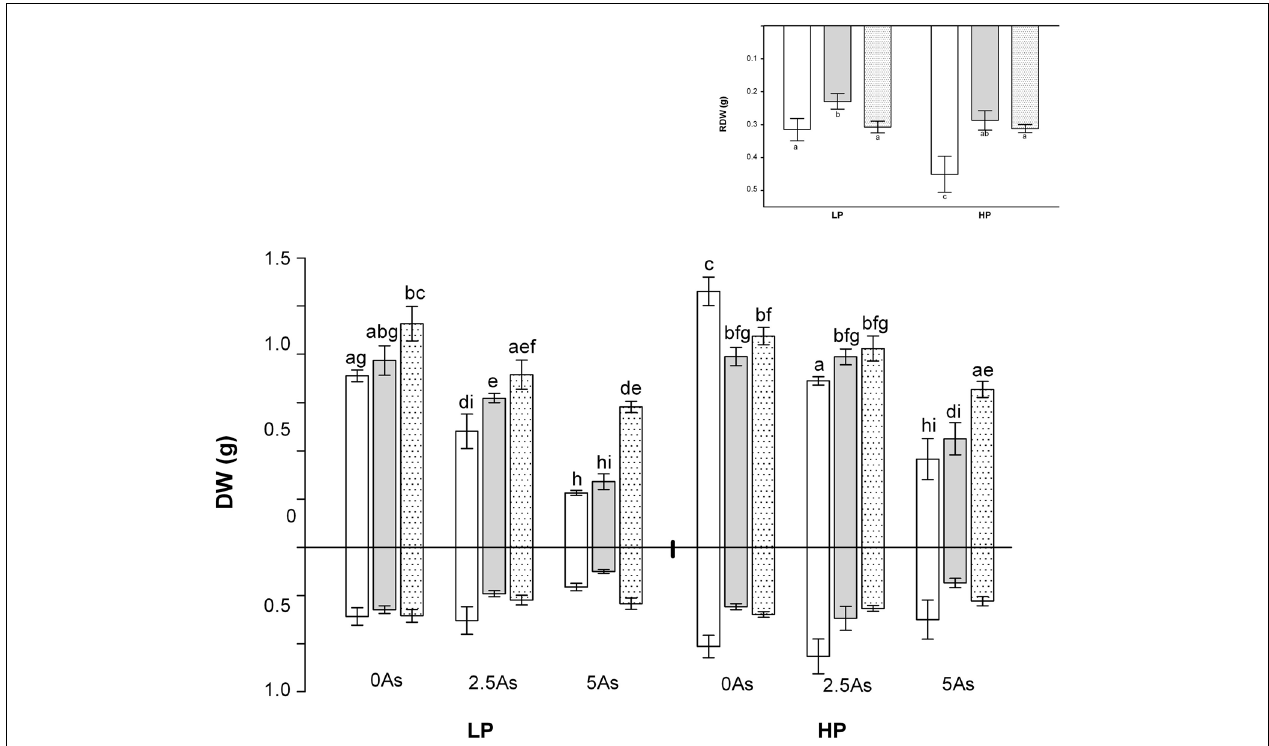
Data are presented as mean values ± SEM ( n = 5 except for treatment group NM, HP5As where n = 3).The interaction between all factors (P, As, and inoculation) was significant ( P = 0.040) for SDW.The interaction between P and inoculation on RDW (illustrated in insert) was significant ( P = 0.007) and independent of the effect of As ( P = 0.0001). In each figure the same letters indicate no significant difference between treatment groups at the 5%